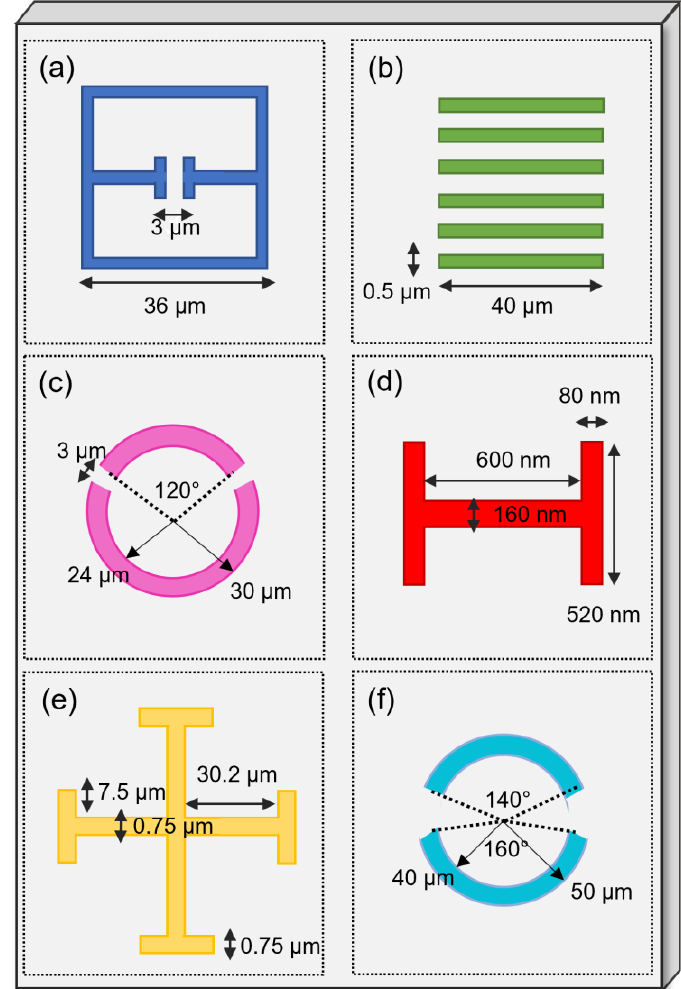
Figure 4. Examples of different geometries adopted for metamaterial unit cells. ( a ) split-ring resonator [82], ( b ) rectangular slot [83], ( c ) double-split ring [114], ( d ) H-shaped resonator [115], ( e ) planar Jerusalem cross [100] and ( f ) asymmetric split-ring resonator. (original figure).